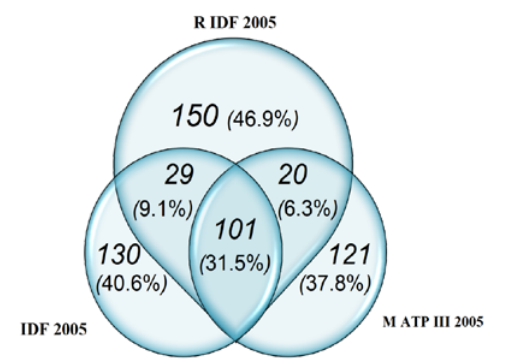
Figure 2: Showing the overlapping of subjects with metabolic syndrome based on the three definitions